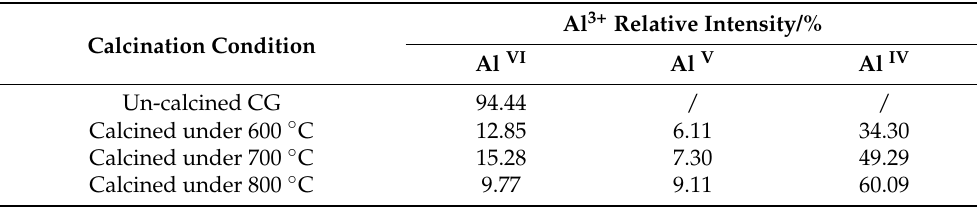
Figure 7. 27 Al NMR of the CG samples after the calcination at different temperatures ( a ) un-calcined CG sample, ( b ) CG sample calcined at 600 ° C , ( c ) CG sample calcined at 700 ° C , and ( d ) CG sample calcined at 800 ° C . Table 4. Calculated relative intensity of 27 Al NMR with various structures in the calcined CG sam- ples.